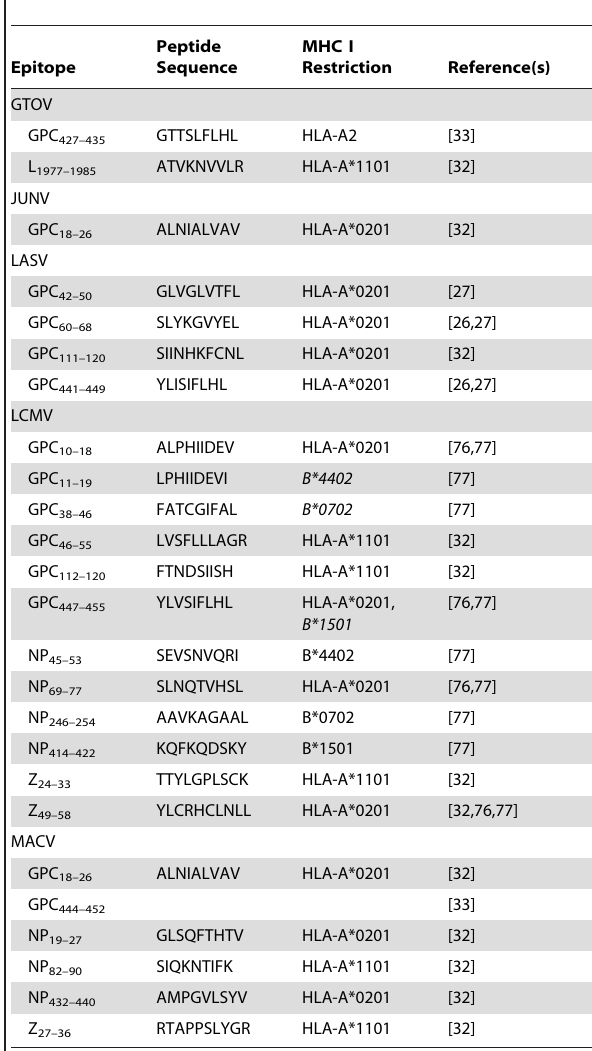
Table 1. Human HLA class I restricted epitopes against pathogenic